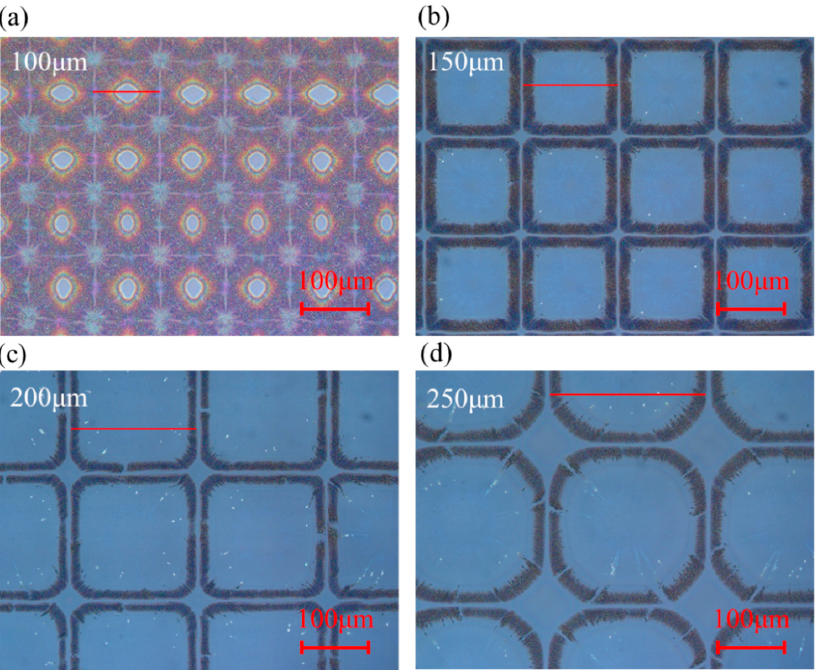
Figure 1. Optical microscopy images of obtained microstructures with different drop spaces: ( a ) 100 μ m, ( b ) 150 μ m, ( c ) 200 μ m, and ( d ) 250 μ m.